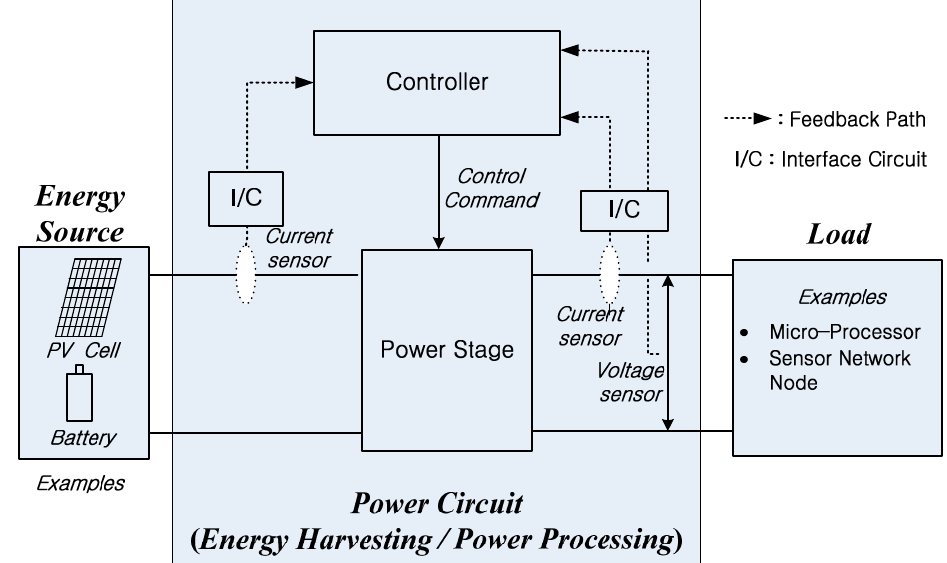
Figure 2. Block diagram of a typical power conversion approach for a WoT connected device.